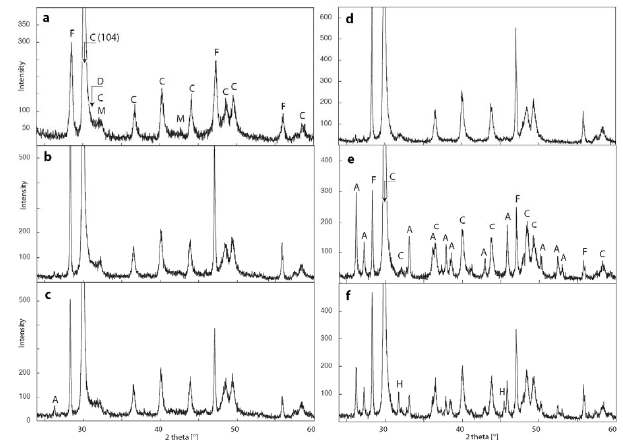
Fig. 8. Powder X-ray diffraction patterns of coralline algae, demon- strating how the presence of protodolomite and magnesite manifests itself in XRD analyses. In examples (a) , (b) and (c) , the calcite 104 reflection has a broad shoulder towards higher angles 2-theta, in- dicative of the presence of significant amounts of protodolomite and magnesite. This is consistent with the high Mg-contents of these samples (26.17–33.33mol% Mg by ICP-AES). In (d) , (e) and (f) , the calcite 104 reflection has no significant shoulder, but displays a strong asymmetry that is typical for biogenic Mg-rich calcite (Mil- liman et al., 1971). This could mask the presence of protodolomite. For easier viewing reflections are labelled in selected scans only: Mg-rich calcite (C), dolomite (D), magnesite (M), fluorite (F), arag- onite (A), halite